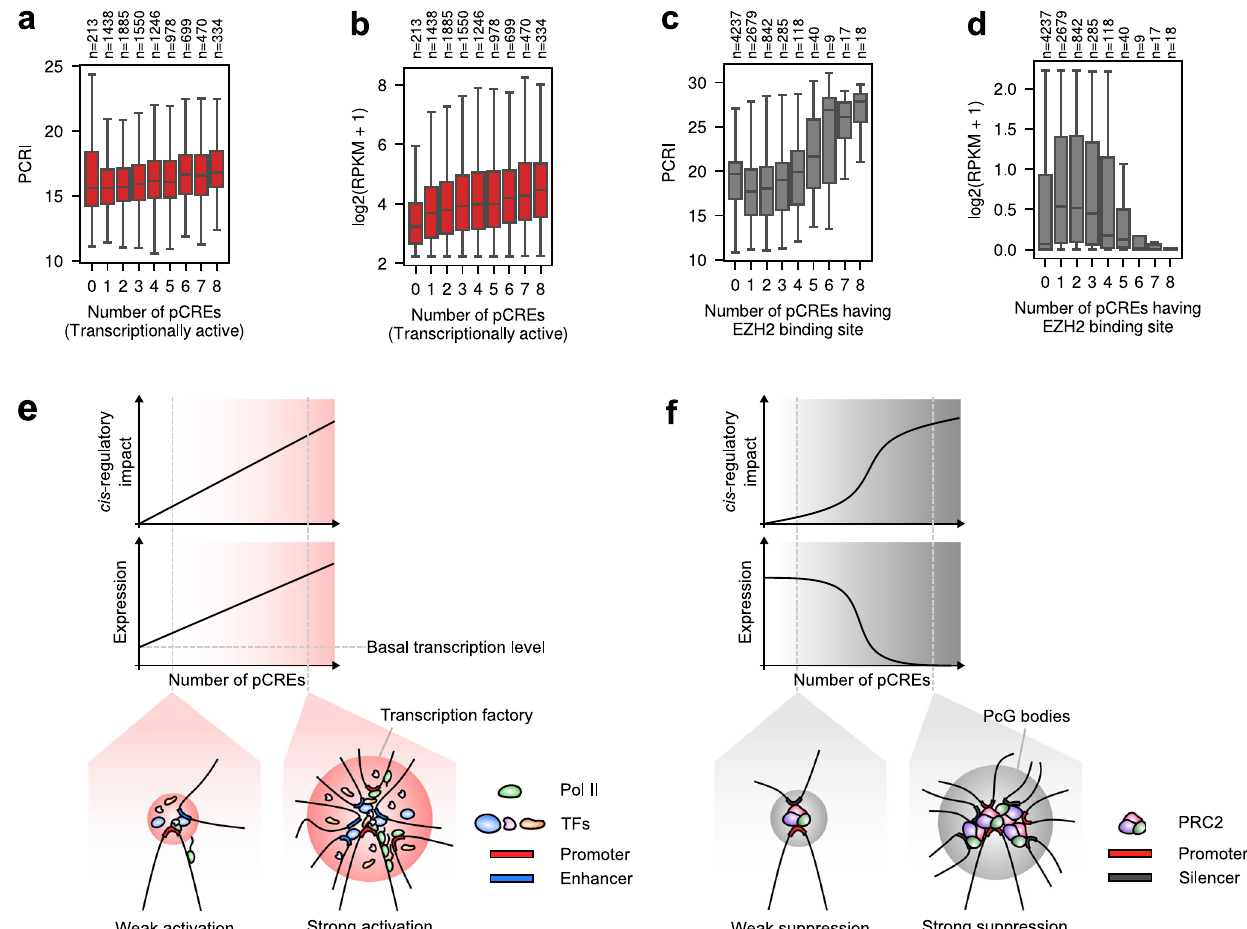
Fig.7|Characteristicsof cis -regulationlearnedbyChromoformer.a Association between the number of transcriptionally active pCREs and PCRI. b Association between the number of transcriptionally active pCREs and gene expression level. c Association between the number of pCREs harboring EZH2 binding sites and PCRI. d Association between the number of pCREs harboring EZH2 binding sites and gene expression level. Throughout a-d, the number of genes having the cor- respondingnumberofpCREsareshownabovetheplot.Intheboxplots,thecenter